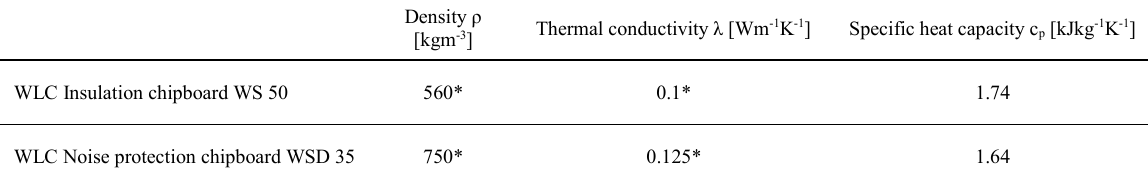
Table 3: Thermal storage capacity properties of prefabricated